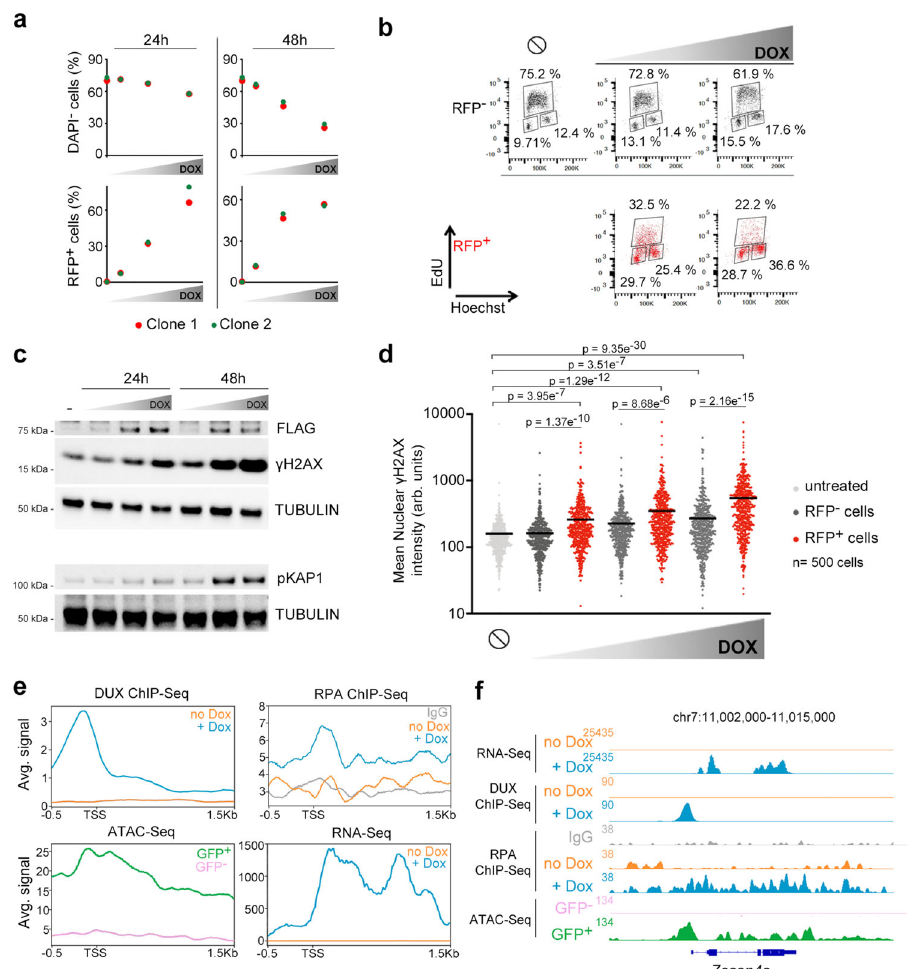
Fig. 1 Induction of 2C-like features in ESC correlated with DNA damage and cell death. a Plots showing the percentage of alive (DAPI − ) and RFP + cells from LTR-RFP reporter ESC DUX treated with increasing doses of DOX (50, 150 and 300 ng/mL) for the indicated time points. Data was collected by fl ow cytometry. b Flow cytometry analysis of the cell cycle distribution in untreated or 150 and 300 ng/mL DOX-treated LTR-RFP reporter ESC DUX for 24 h. Percentages for each phase of the cell cycle are included. c Western blot analysis of the indicated proteins performed in ESC DUX treated with different doses of DOX (150, 300 and 600 ng/mL) for the indicated time points. Expression of DUX was monitored by its FLAG-tag. Tubulin levels are shown as a loading control. d High-throughput imaging (HTI) quanti fi cation of γ H2AX in LTR-RFP reporter ESC DUX treated with different concentrations of DOX (150, 300 and 600 ng/mL) for 24 h. Center lines indicate mean values. ∅ = No treatment. n = 500; p -values are shown from two-tailed unpaired t -tests.